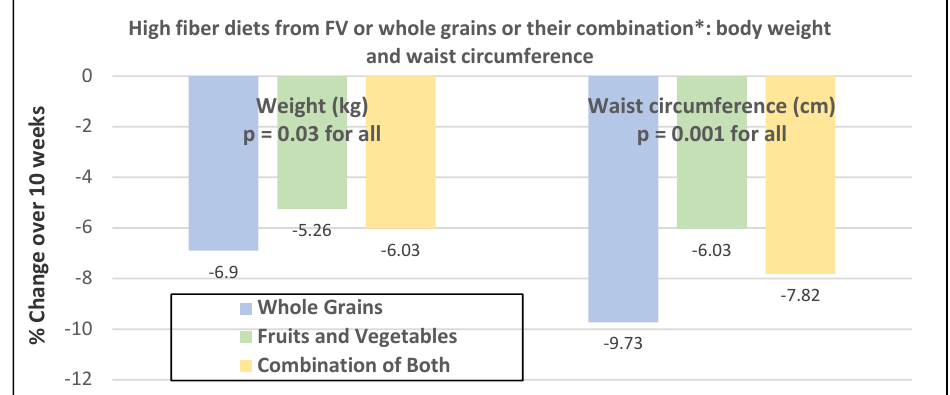
Premenopausal women—dietary approach #4—increasing high fiber diets from FV and/or